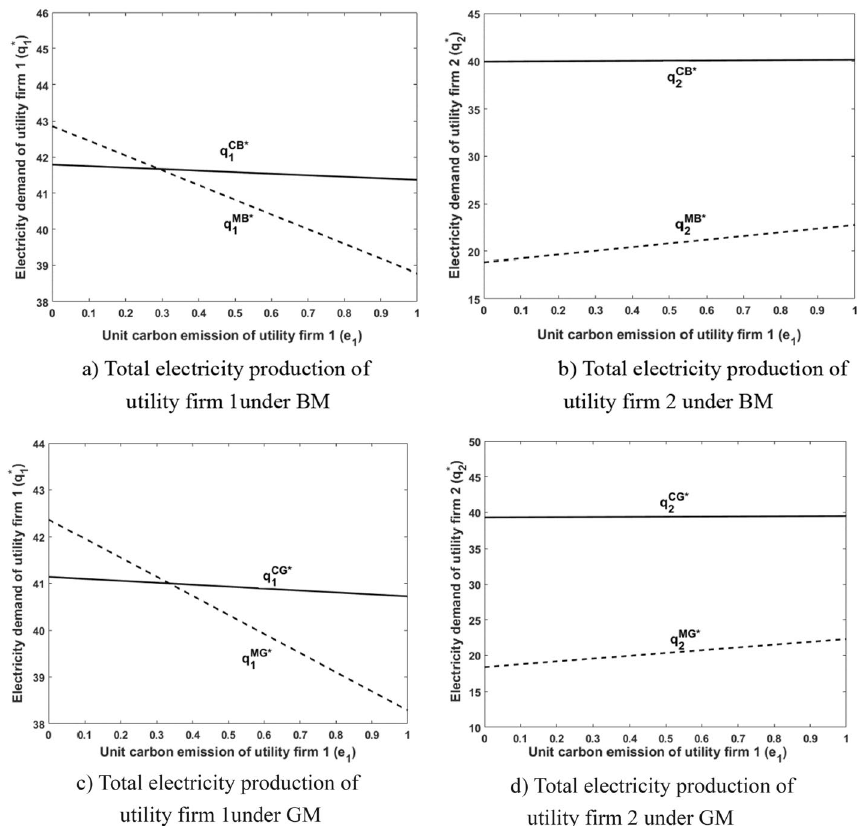
Fig. 4 Impact of unit carbon emission on electricity